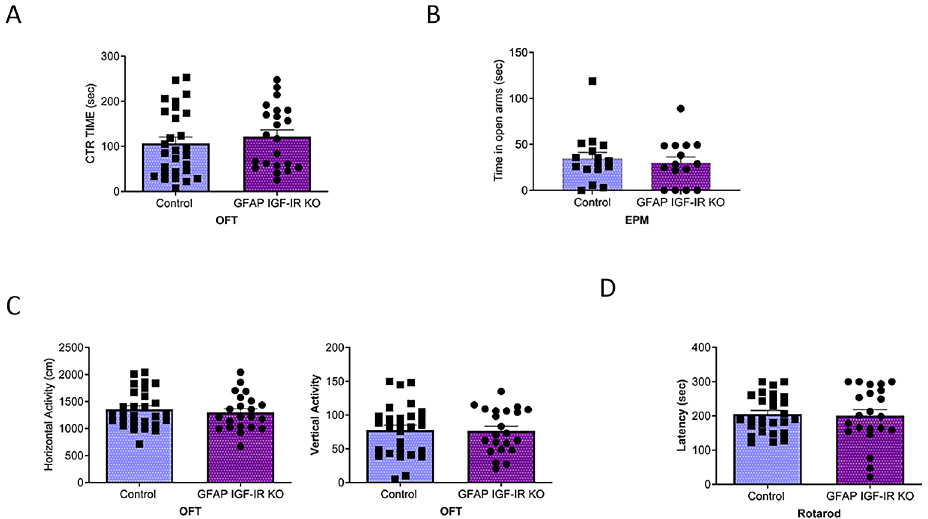
Figure 4. Mood homeostasis in GFAP IGF-IR KO mice. A, No differences in time spent in the center of an open field were observed between littermates and mutant GFAP IGF-IR KO mice (control n=28, GFAP IGF-IR KO n=22, t-test, t=0.73, p=0.46). B, No differences were observed in anxiety levels determined in the EPM between GFAP-IGF-IR KO and littermates (control n=16, GFAP IGF-IR KO n=15, t-test, t=0.48, p=0.63). C, No differences were observed in horizontal (left histograms) and vertical (right) activity in the open field arena was observed between GFAP IGF-IR KO miceand littermates (control n=28,GFAP IRKO n=22,H: t-test, t=0.61,p=0.54; V:t-test, t=0.12,p=0.90). D,Control and GFAP-IGF-IRKOmiceshowsimilarlevelsofmotorcoordination,asassessedintherota-rod(controln=22,GFAPIRKO n=27, t-test, t=0.22,